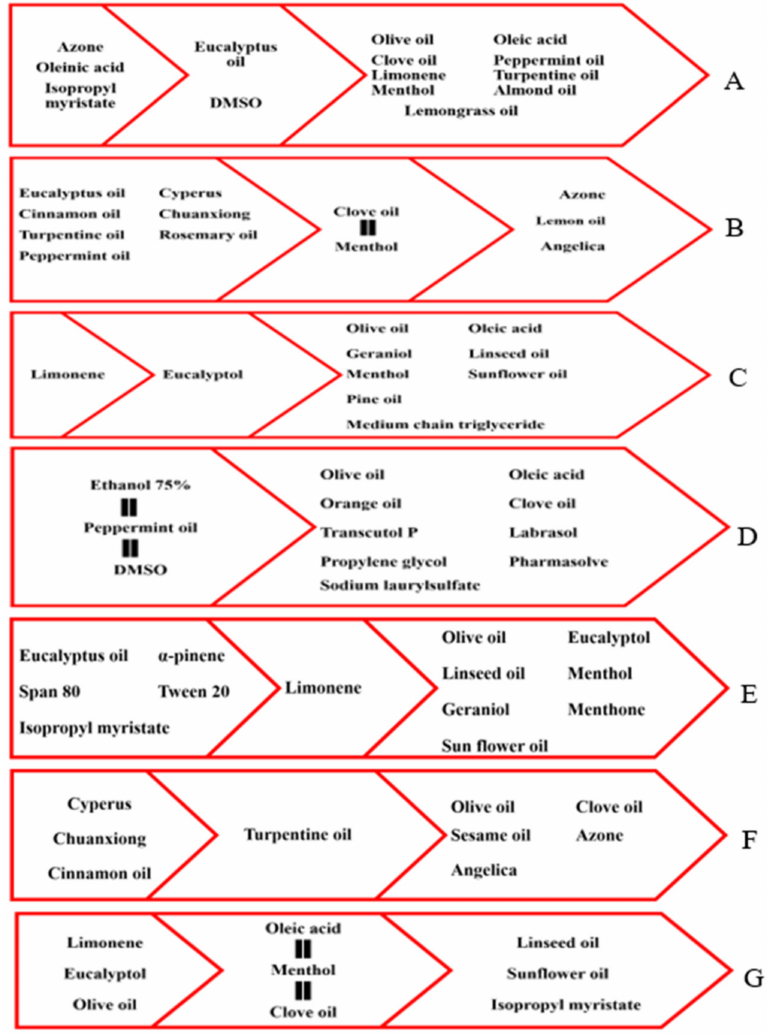
Figure 7. Summary of permeation enhancement activity of terpene essential oils as compared to other chemical enhancers, ( A ) eucalyptus oil, ( B ) clove oil, ( C ) eucalyptol, ( D ) peppermint oil, ( E ) limonene, ( F ) turpentine oil, and ( G )